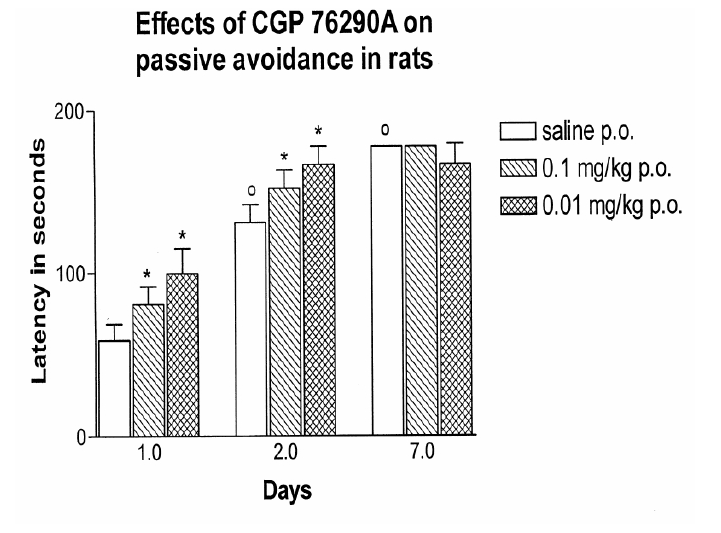
Fig. 6 Effects of GABA B receptor antagonist CGP76290A on learning and memory re- tention in rats on passive avoidance test. Abscissa - days of testing; Ordinate - latency(s). o P < 0 . 05 compared to the 1 st day control. ∗ P < 0 . 05 and ∗∗ P < 0 . 01 compared to the respective